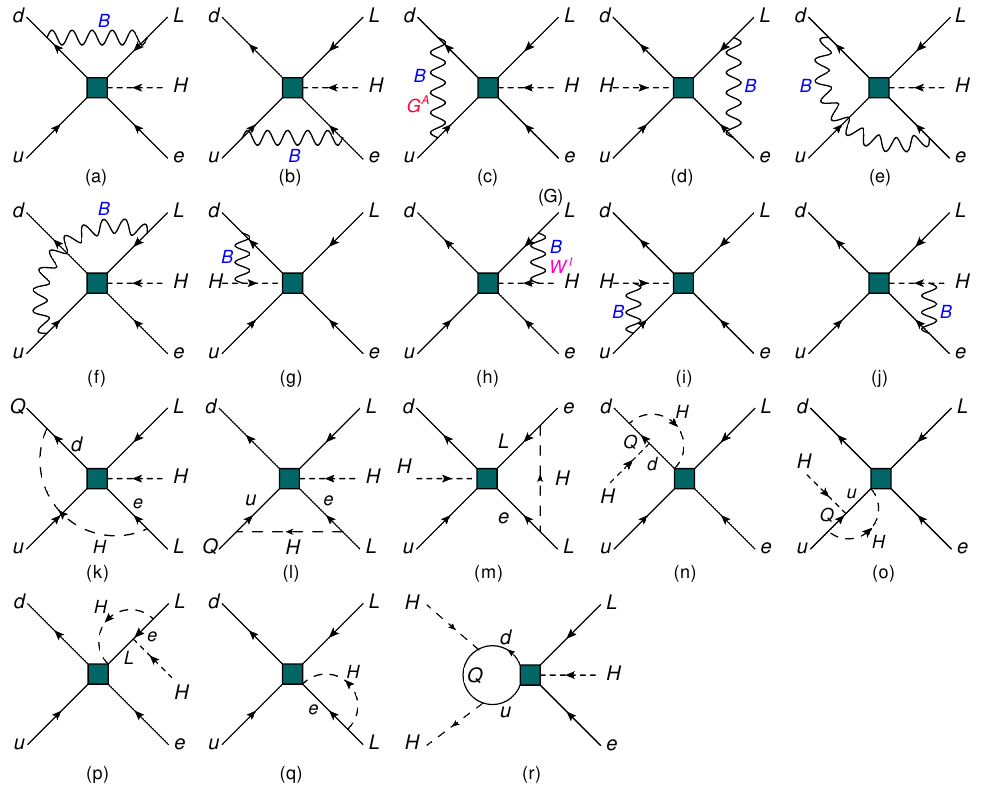
Figure 3 . One-loop Feynman diagrams with an insertion of the e(cid:11)ective interaction ( C O ) (cid:22)